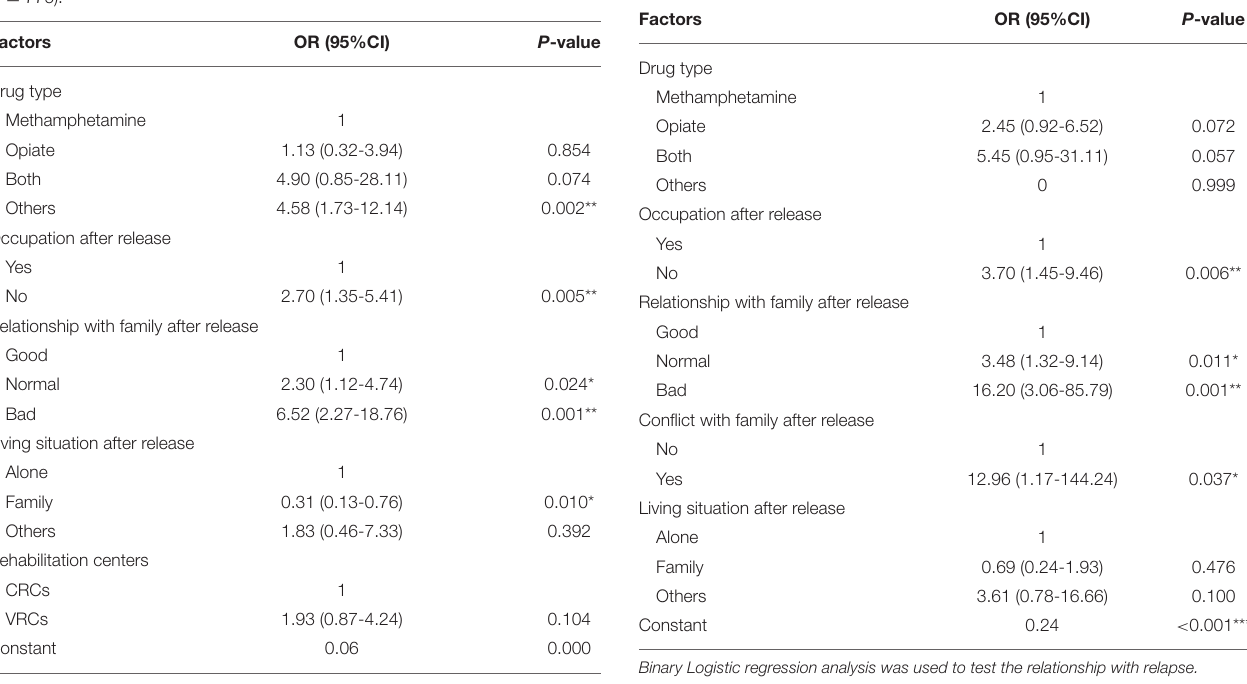
TABLE 4 | Binary logistic analysis for all participants from both CRCs and VRCs ( n = 776). Factors